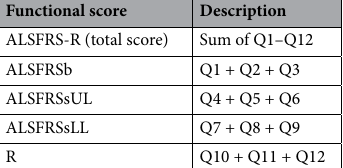
Functional score